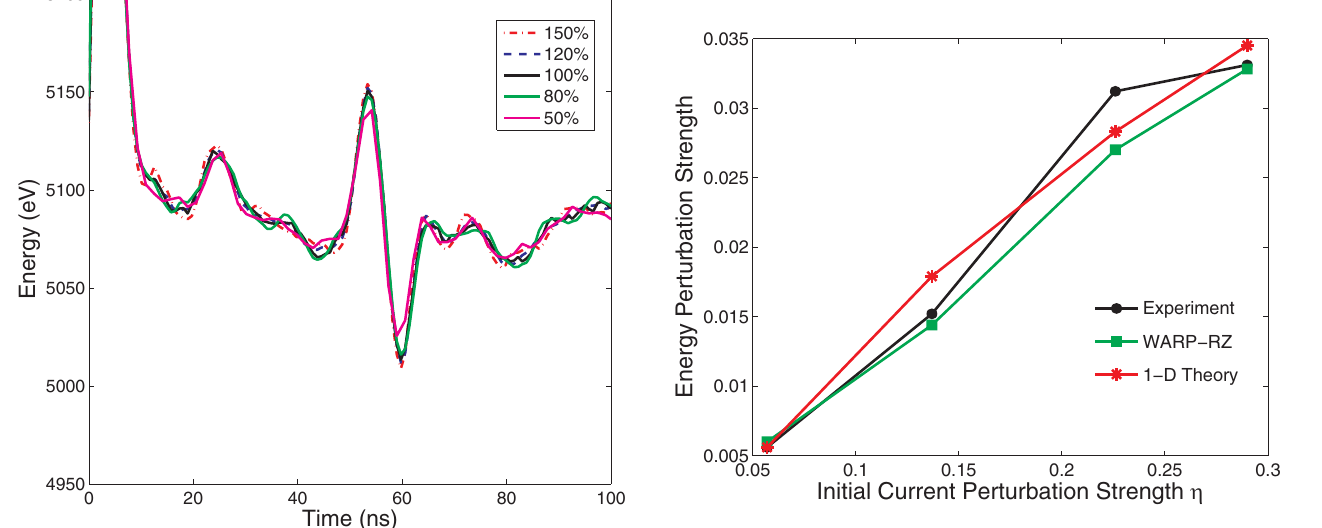
FIG. 6. (Color) The results of mean energy vs time for different beam radius in WARP